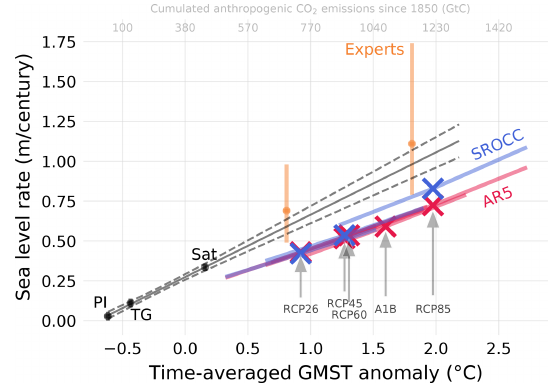
Figure 2. The rate of sea level rise versus long-term average temper- ature as seen in observations (black), model projections (red/blue), and expectations in an expert elicitation (orange). Each point repre- sents an average over a time period (PI: 1850–1900; TG: 1900– 1990; SAT: 1993–2017; AR5/SROCC/experts: 2000–2100). Sea level projections as assessed in AR5 and SROCC systematically fall below what would be expected from extrapolating observations to warmer conditions, as well as below the expert elicitation. Error bars show estimated likely ranges (17%–83%). Likely ranges for SROCC and AR5 are shown as slanted error